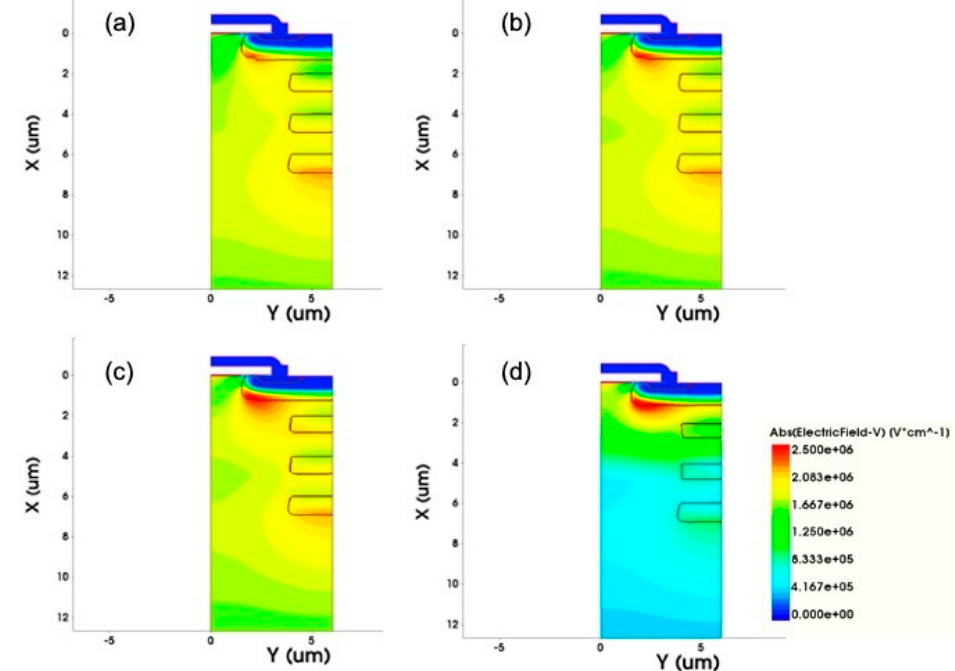
Figure 5. Electric field distributions of different N1 epitaxial layer concentrations: normalized N1 concentration ratio of ( a ) 0.6, ( b ) 0.8, ( c ) 1, ( d ) 3.